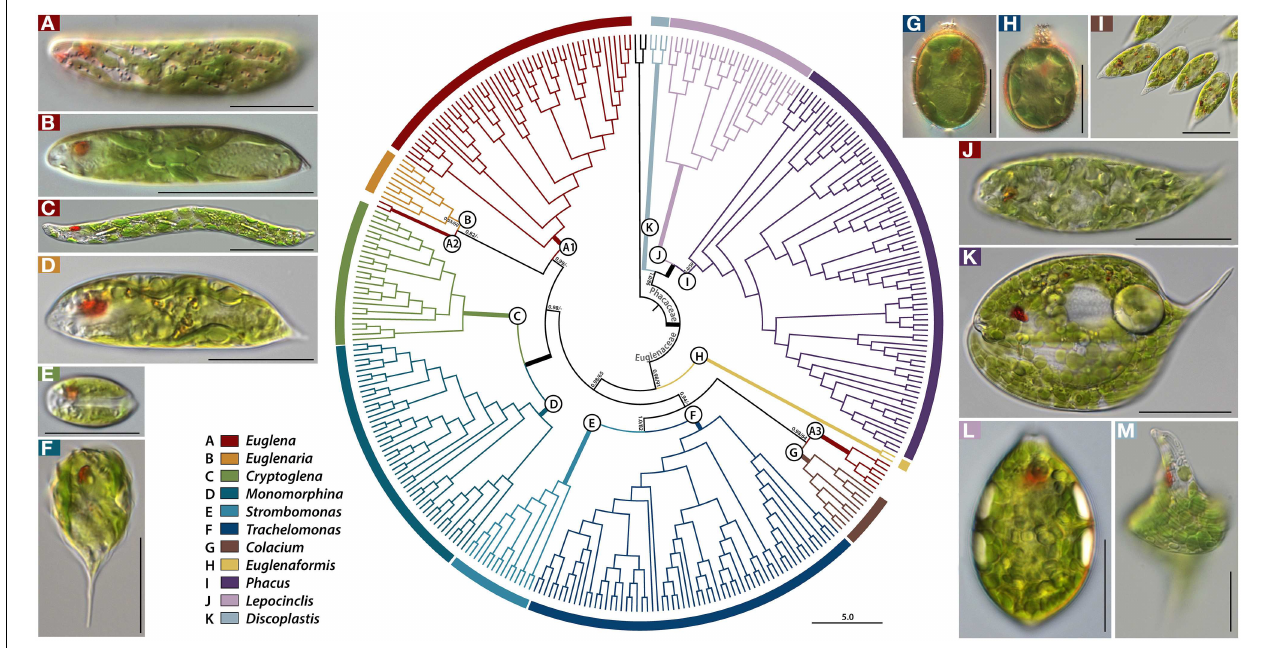
diplopyrenoid in larger discoid chloroplast; (H) Trachelomonas sp. with haplopyrenoid in larger discoid chloroplast; (I) Colacium sp. Songjanggol033107B with haplopyrenoid in larger discoid chloroplast; (J) Euglena cf. velata with diplopyrenoid in deeply lobed chloroplast; (K) Phacus orbicularis with small discoid chloroplasts; (L) Lepocinclis ovum with small discoid chloroplast; (M) Discoplastis spathirhyncha with small discoid chloroplast. The numbers on each node represents posterior probabilities (left) and bootstrapping values (right). The bold branches indicate strongly supported values (pp = 1.00 and ML = 100%). Scale bars in pictures, 20 µ m.